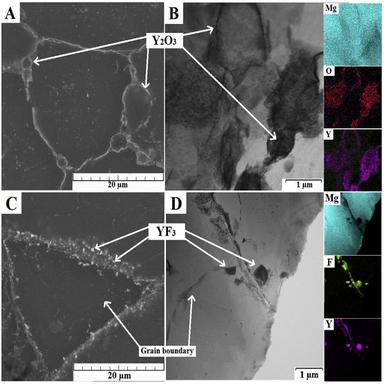
Microstructure - SEM and TEM with EDS analysis A, B) WE43 and C), D) WE43 24h HF.